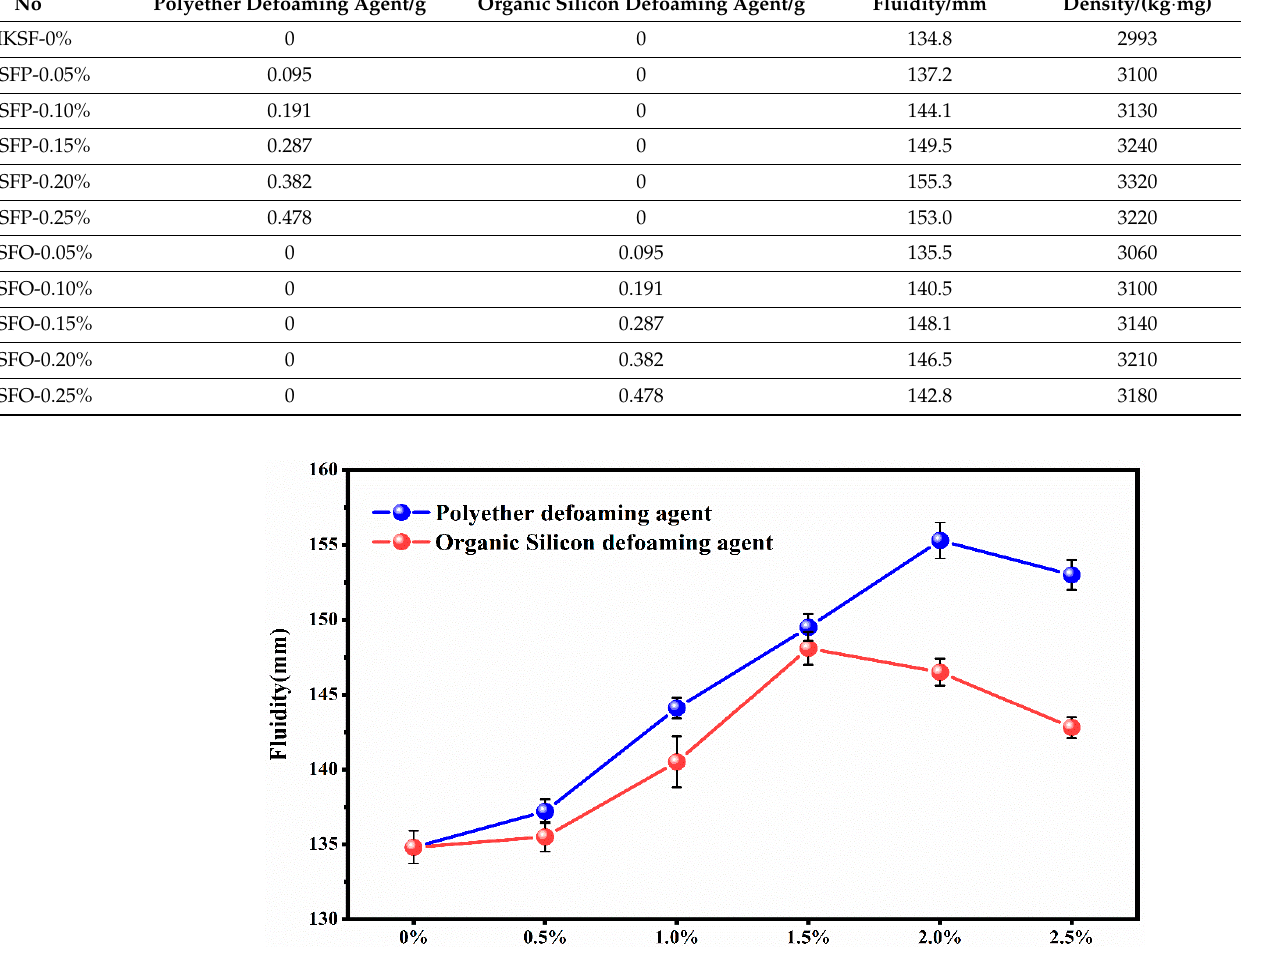
Figure 8. Mobility. Figure 8.